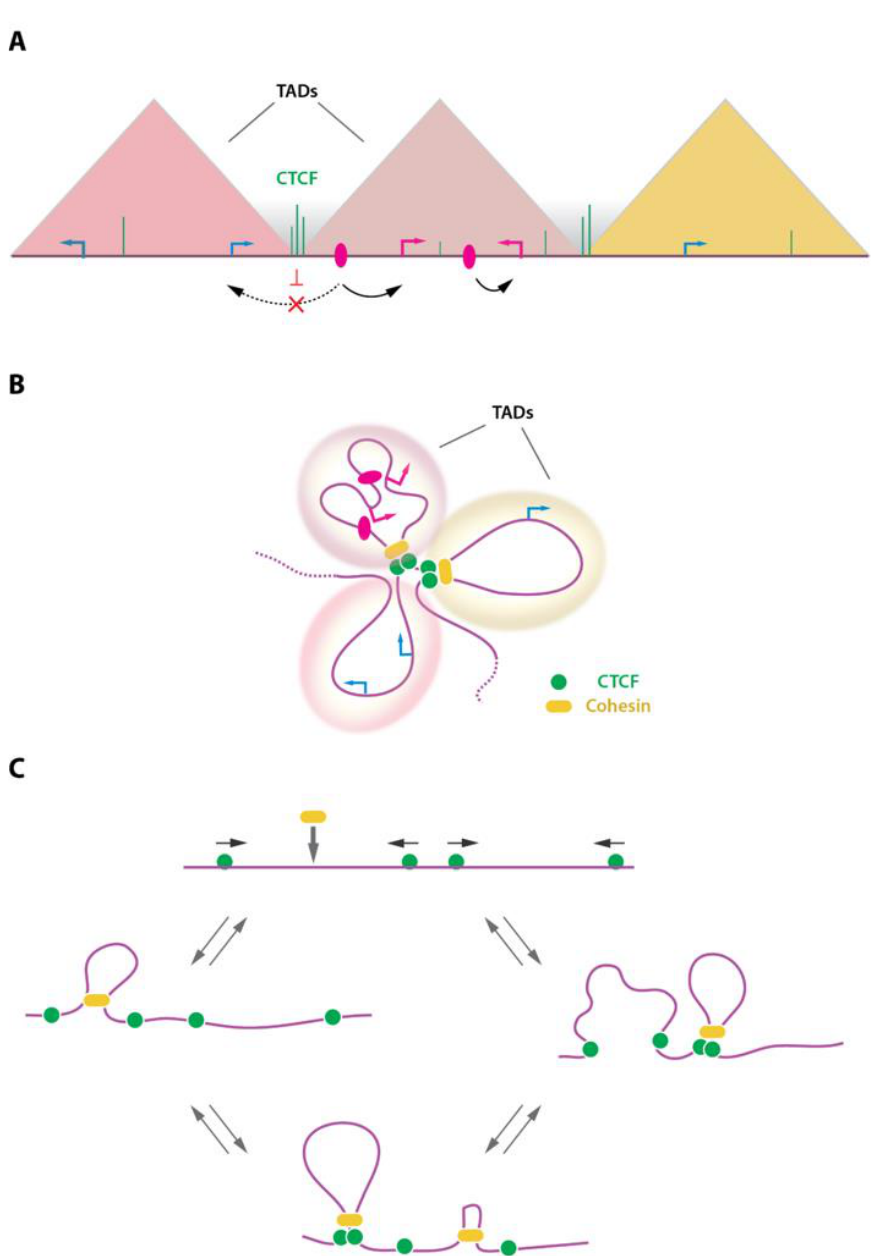
Figure 3. TADs and the loop extrusion process. ( A ) Schematic representation of TADs (triangles) as observed in Hi-C contact maps. TADs represent domains of favored chromatin interactions. As a consequence, enhancer (pink ovals)-promoter interactions are favored within TADs (black arrows) and disfavored across TADs (dashed arrow). TADs are separated by borders, often enriched in CTCF binding sites, which may contribute to prevent interactions between domains. ( B ) TADs representation as folded chromatin. TADs are formed and stabilized by the action of CTCF and the cohesin complex. ( C ) The loop extrusion model is depicted showing recruitment of the ring-shaped cohesin complex onto the genome where it initiates DNA extrusion, forming a chromatin loop. The cohesin complex stalls are convergently oriented CTCF sites. This process is dynamic and assembles/disassembles continuously as a function of CTCF and cohesin residence time on chromatin. Arrows on top of CTCF (green circles) indicate the orientation of the underlying DNA motif.